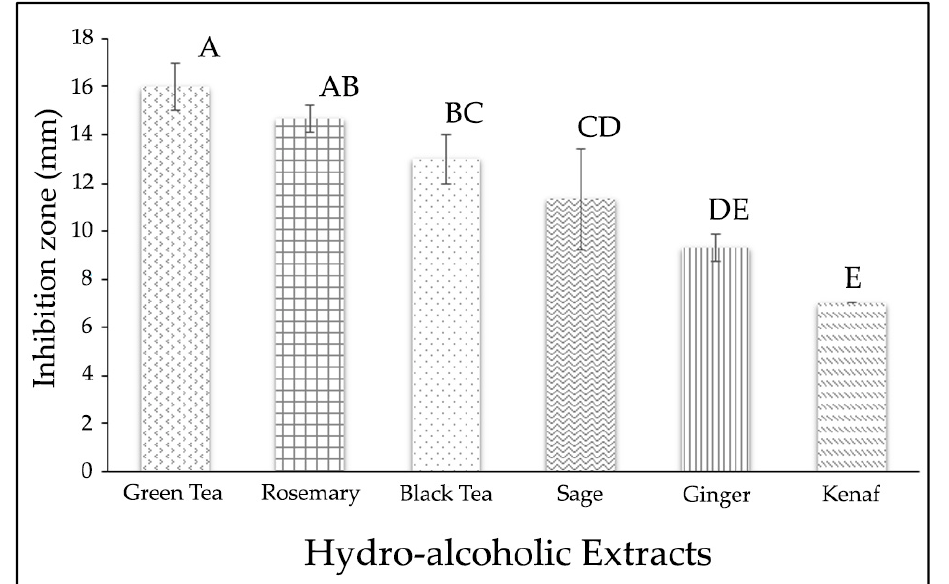
Figure 1. In vitro antimicrobial activity of pure HAE against B. cereus . A–E: Means with different letters indicate significant differences between HAE ( p < 0.05).